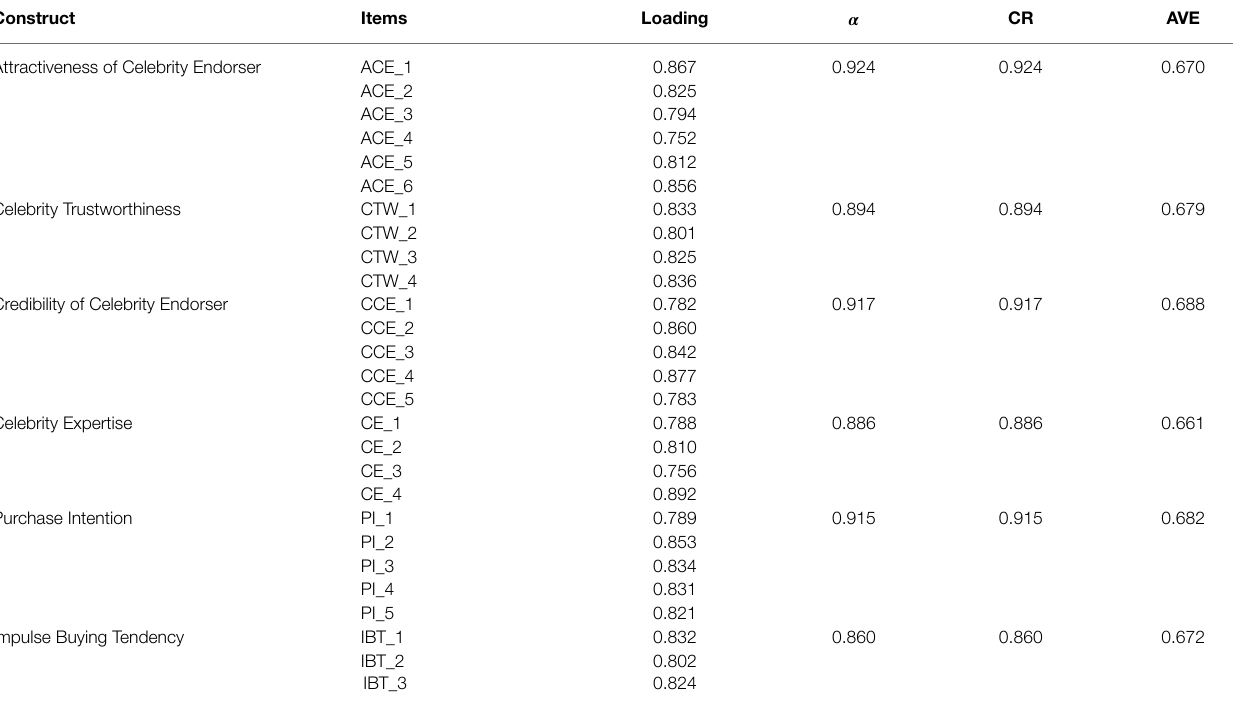
TABLE 2 | Reliability and validity